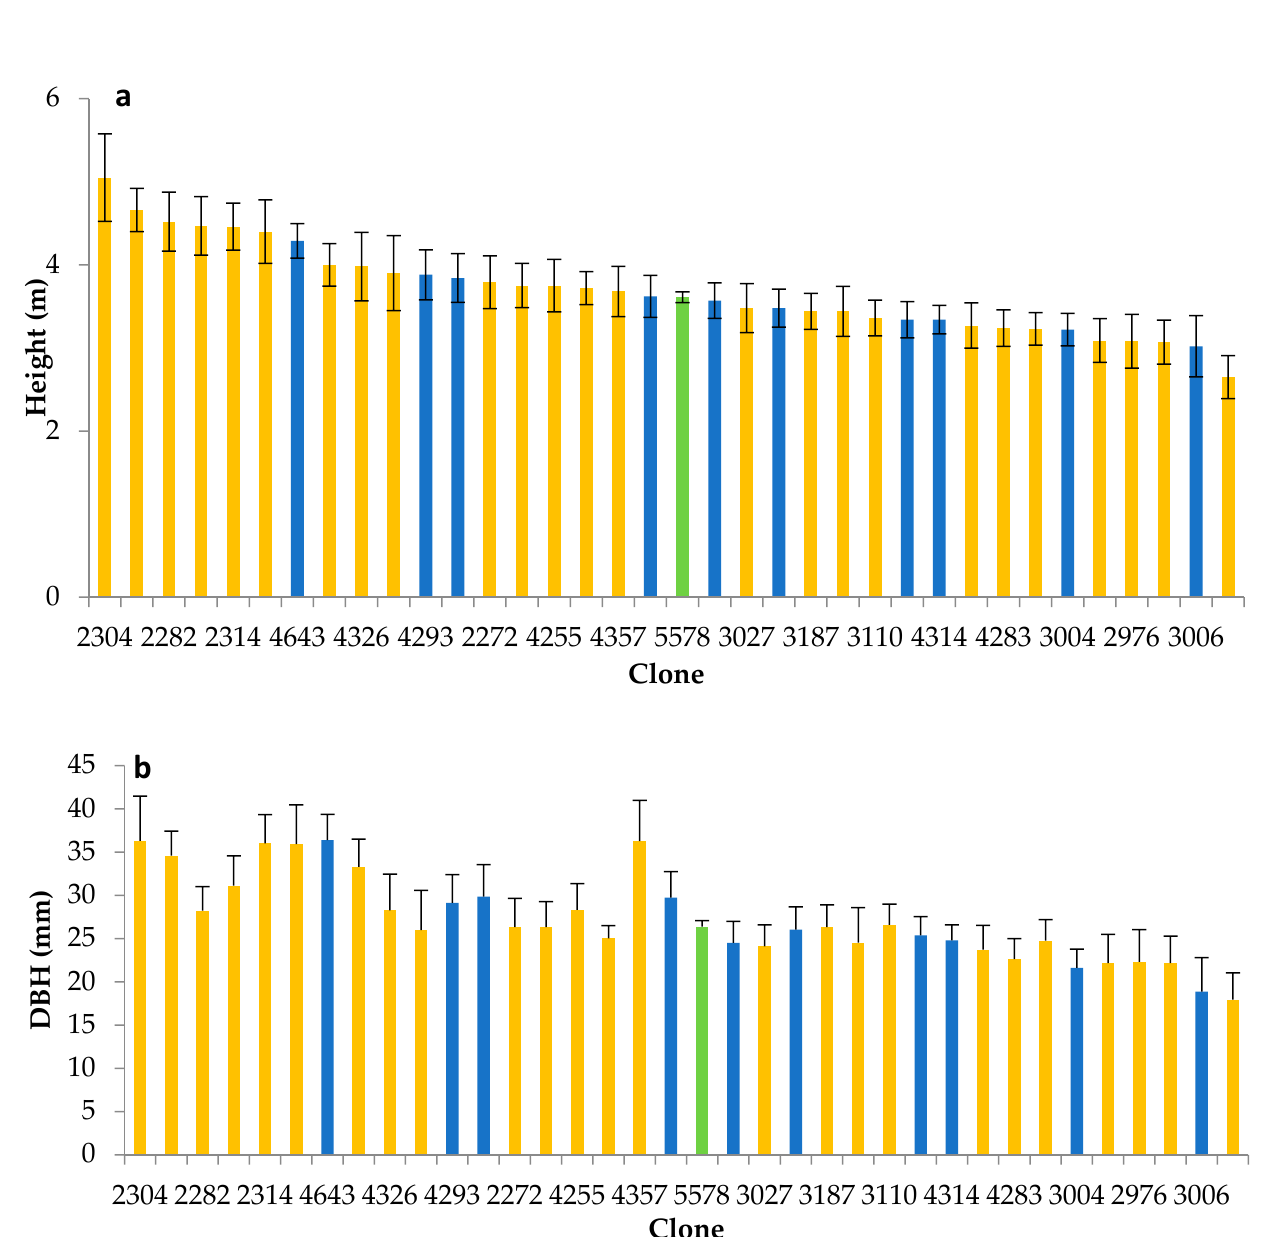
Figure 7. Mean growth ( ± SE) by balsam poplar clone (fall 2019). The yellow bars are treatment 1 clones, the dark blue bars are treatment 2 clones, and the green bar is treatment 3 (treatment 1 = 25 selected tolerant clones, treatment 2 = 10 selected control clones, treatment 3 = Stream 1 vegetative lot clones; # 5578 was the lot number for all Stream 1 clones). ( a ) Height (m); ( b ) DBH (mm).